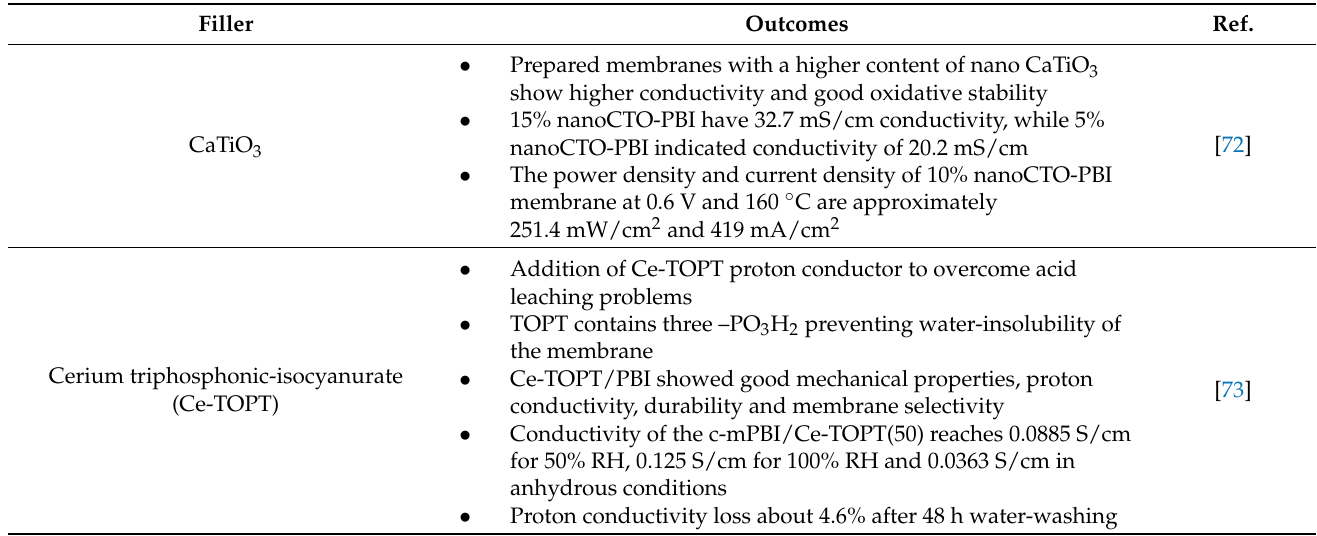
Table 2. Several examples of fillers used in the preparation of PBI polymers. Filler Outcomes Ref.